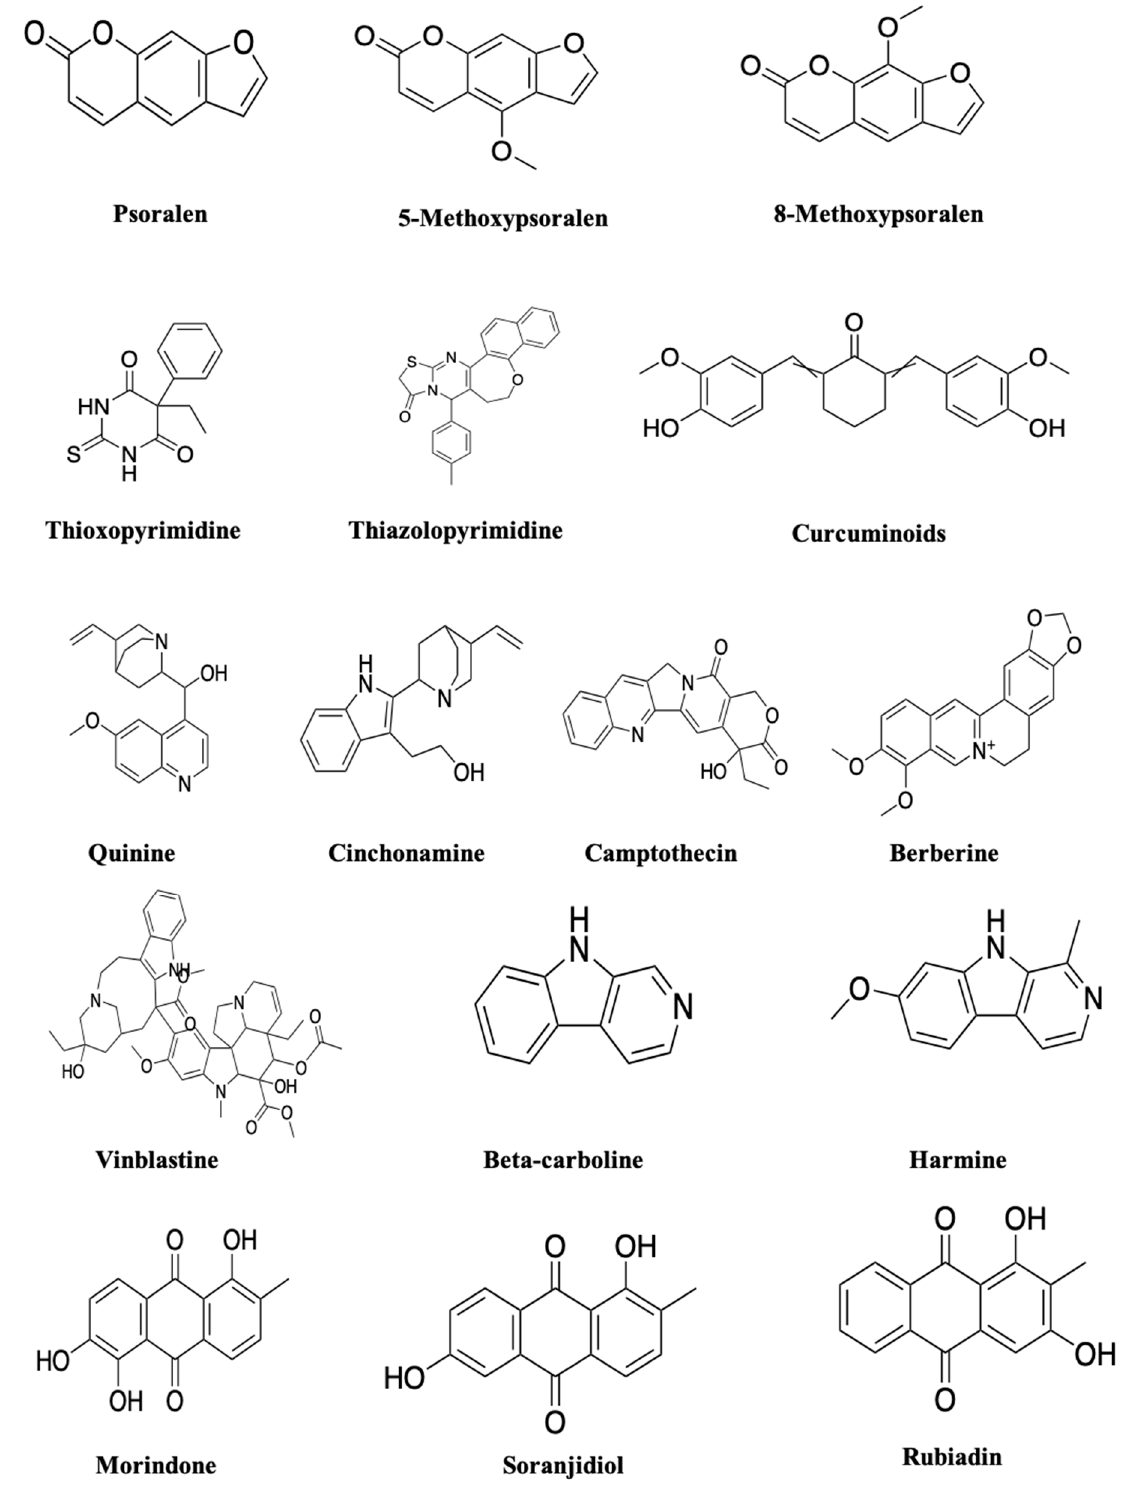
Figure 3. Natural photoactive compounds presented in this review.